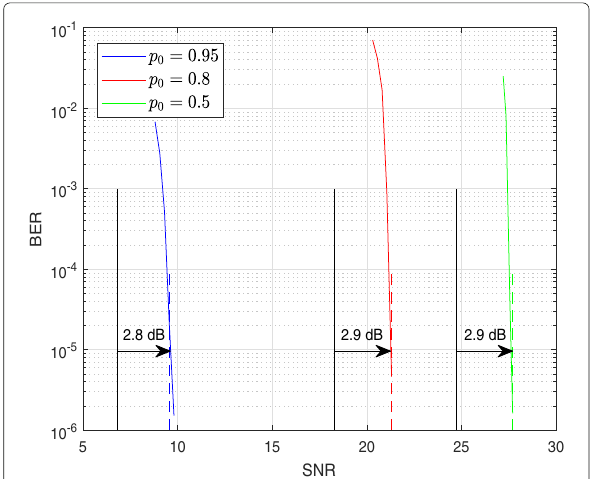
Fig. 11 BER vs SNR obtained by Monte Carlo simulations for fast fading Rayleigh channels. The Shannon limits (continuous lines) and the predicted decoding threshold (dashed lines) are plotted as vertical